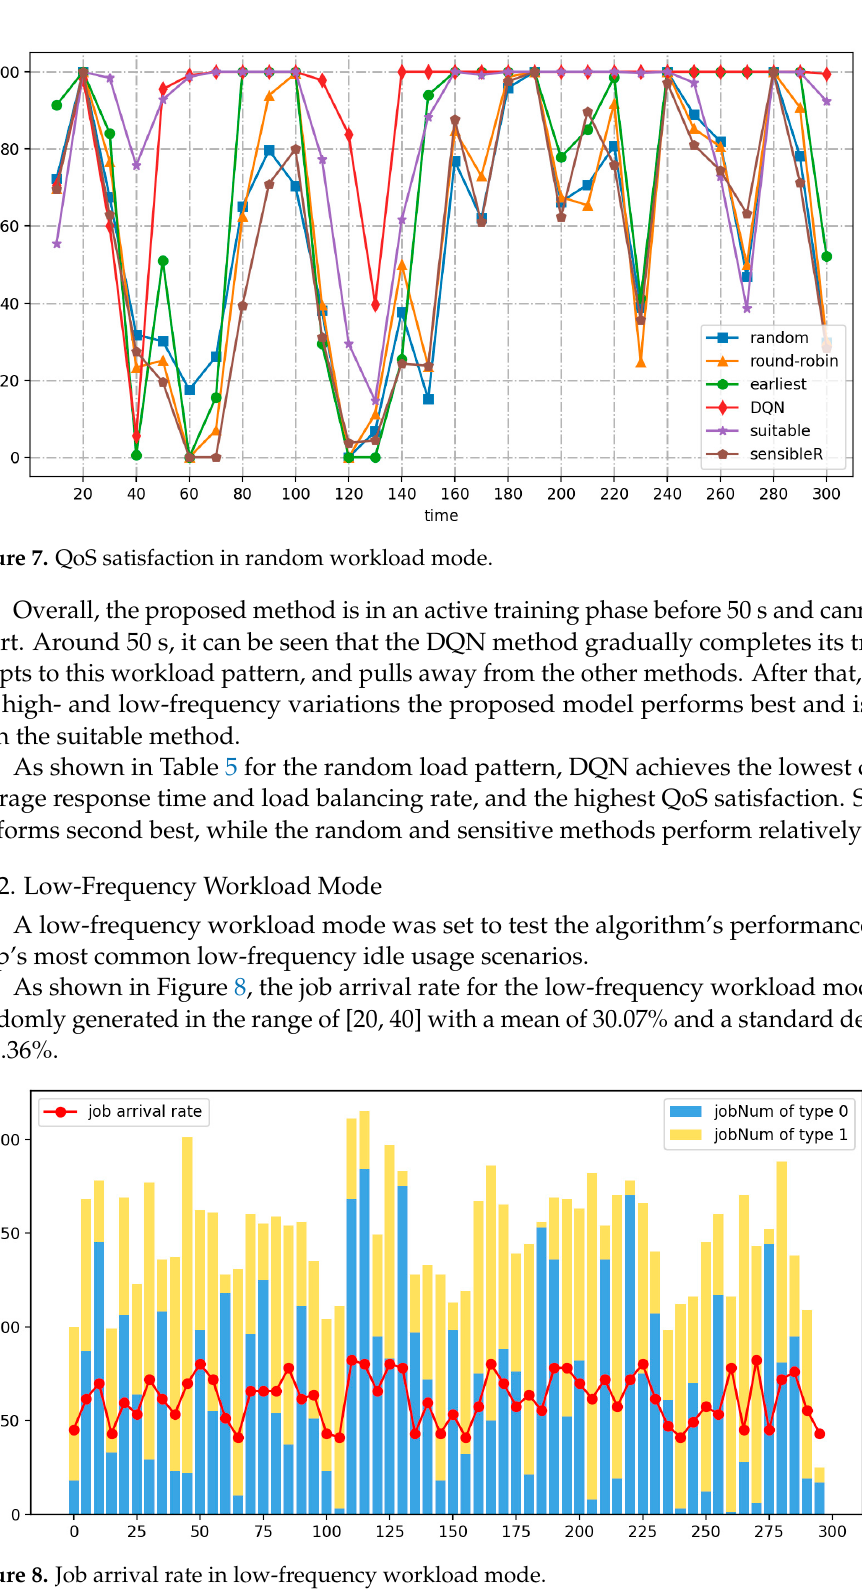
Figure 6. Average response time in random workload mode.